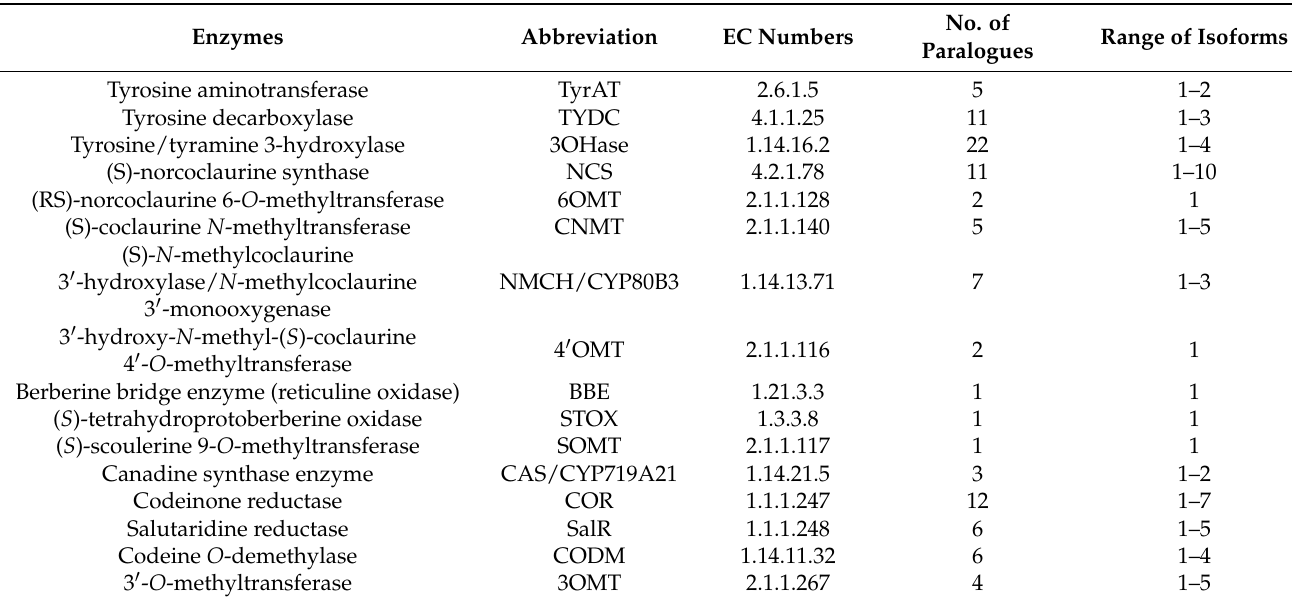
Table 1. Number of paralogues and isoforms of the enzymes involved in benzylisoquinoline alkaloid biosynthetic pathway in B. koreana